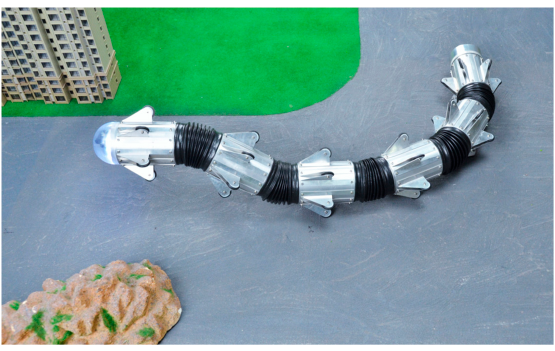
Figure 12. Snake robot body.